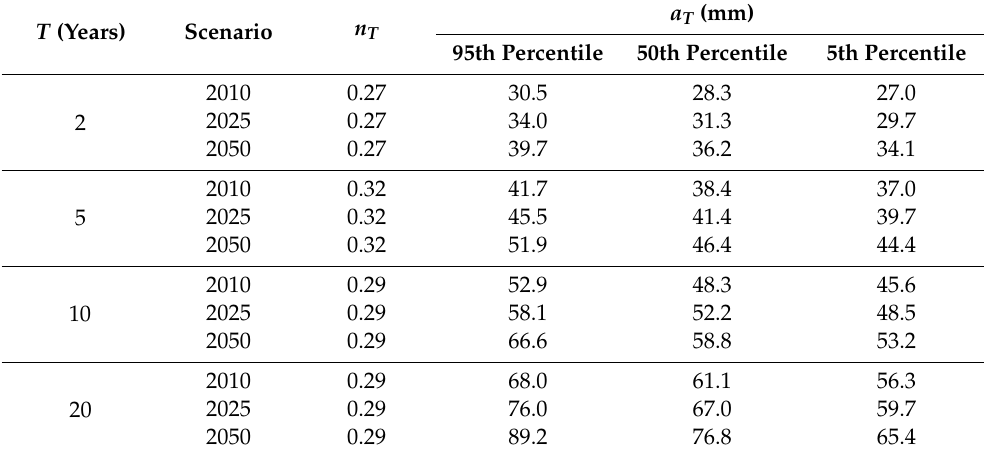
Table 1. Parameters n T and a T of depth–duration–frequency (DDF) curves for each scenario and return period T